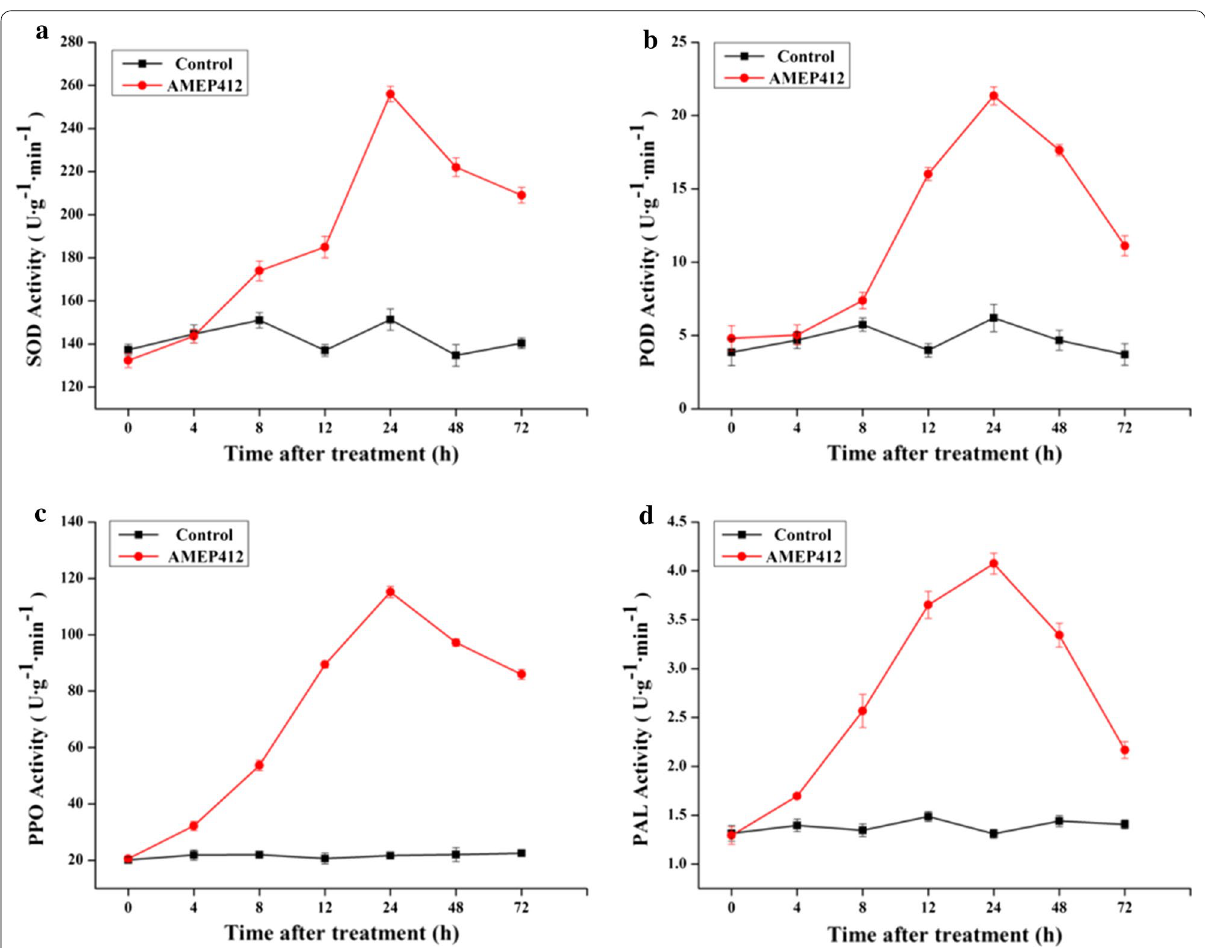
Fig. 6 Kinetics of SOD, POD, PPO and PAL activity after AMEP412 treatment. The activities were measured 0–72 h after AMEP412 treatment. The values are the mean SD of quintuplicate ±